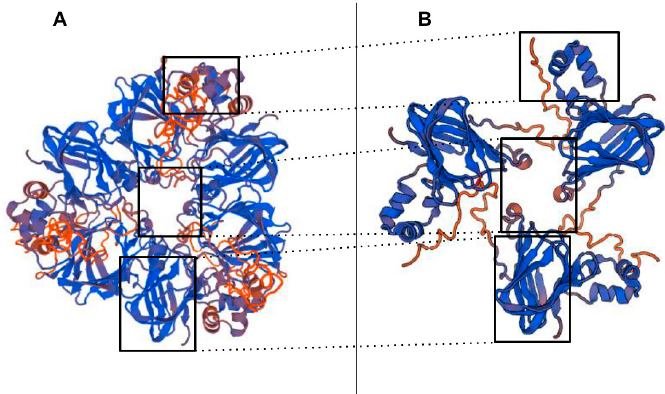
Figure 8. The 11S globulins are hexameric proteins with subunits comprising an acidic polypeptide 30–40 kDa in size that is disulphide-linked to a 20 kDa basic polypeptide. ( A ) SWISS-MODEL of a homo-trimer of pistachio 11S globulin seed storage protein (ABU42022), ( B ) SWISS-MODEL of the basic subunit homo-trimer recognised by PVF4-dAb, the rectangles show the possible epitope recognition zones.